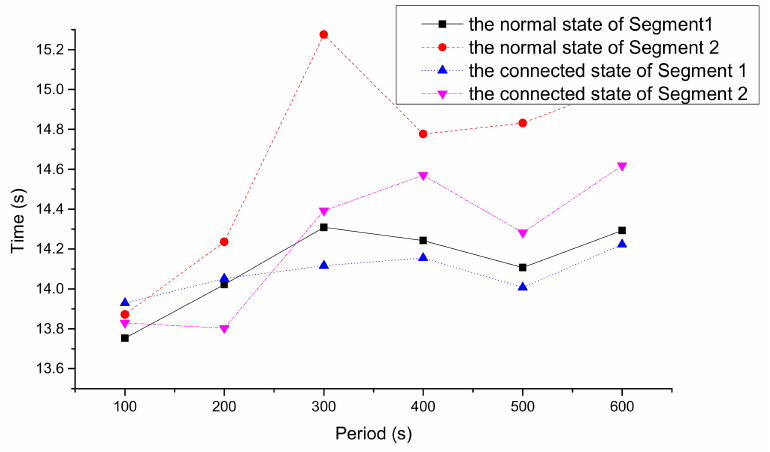
Figure 8. Average travel time in two states.